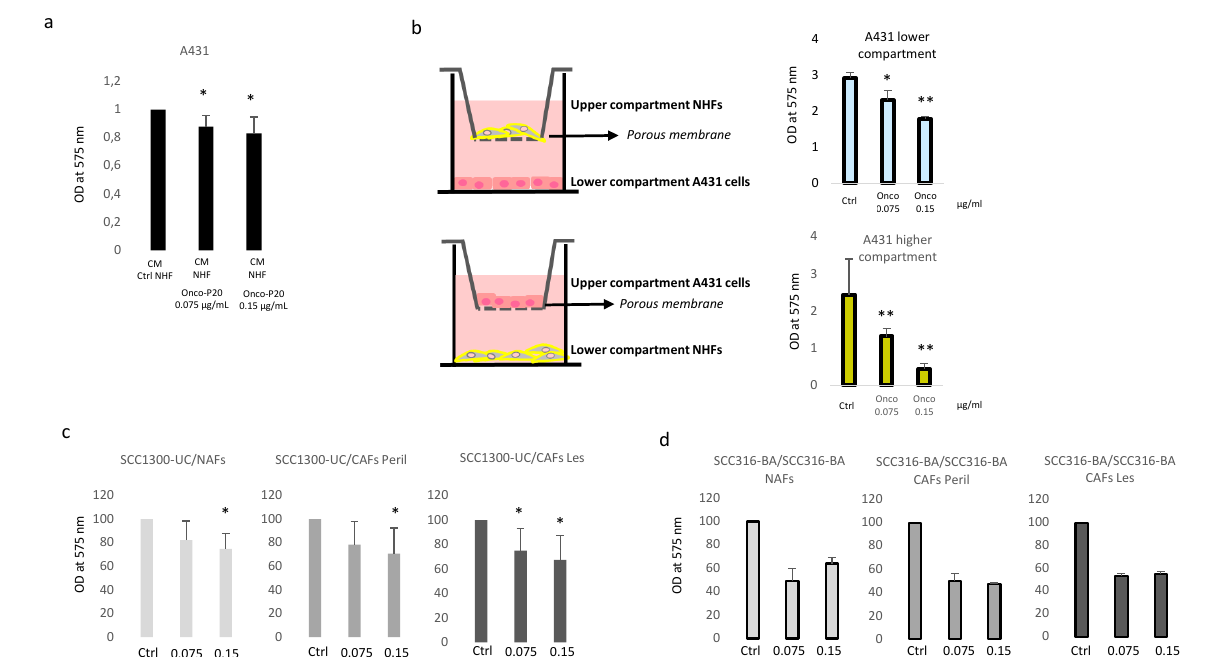
Figure 7. ( a ) MTT assay of A431 carcinoma cells grown in the presence of CM collected from Onco-P20-treated fibroblasts. After 2 weeks and an additional 48 h period without treatment, the medium was replaced with M154 without supplements before CM harvesting. CM was diluted 1:5 in fresh M154. CM of untreated fibroblasts was used as a control medium. Histograms represent the mean ± SD of three independent experiments performed with three different NHF cell lines at the experimental end point (72 h). ( b ) Schematic representation of the trans-well systems used for co-culture experiments. MTT assay after 72 h of A431 cells in the co-culture demonstrated dose-dependent anti-cancer activity of Onco-P20-treated normal fibroblasts. ( c ) MTT assay after 72 h of SCC1300-UC carcinoma cells in the co-culture with fibroblasts isolated from uninvolved (NAFs), perilesional, and lesional areas (CAFs) of carcinoma patients. Results report data relative to three independent experiments performed with three different donors. ( d ) MTT assay after 72 h of SCC316-BA carcinoma cells in the co-culture with matched fibroblasts isolated from uninvolved (NAFs), perilesional (CAFs Peril), and lesional (CAFs Les) areas of the same donor (SCC316-BA). Statistical significance versus untreated control cells is reported as * p < 0.05 and ** p <